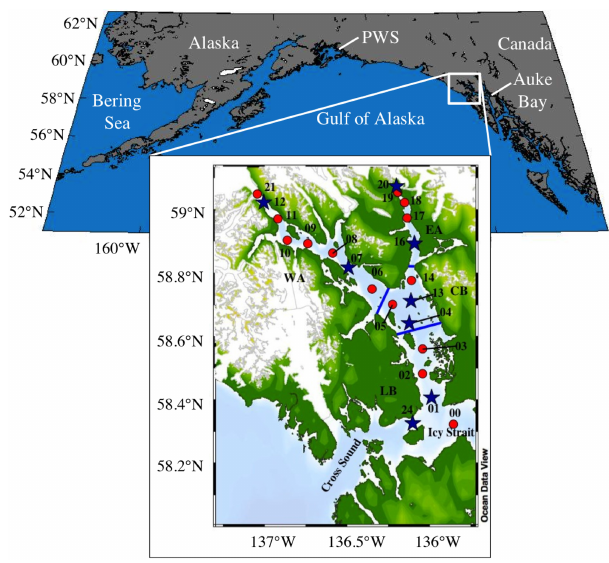
Figure 1. Glacier Bay location and oceanographic sampling station map. Blue lines denote regional boundaries between lower bay, cen- tral bay, east arm, and west arm. Red dots show all oceanographic station locations with station number. Blue stars represent “core” station